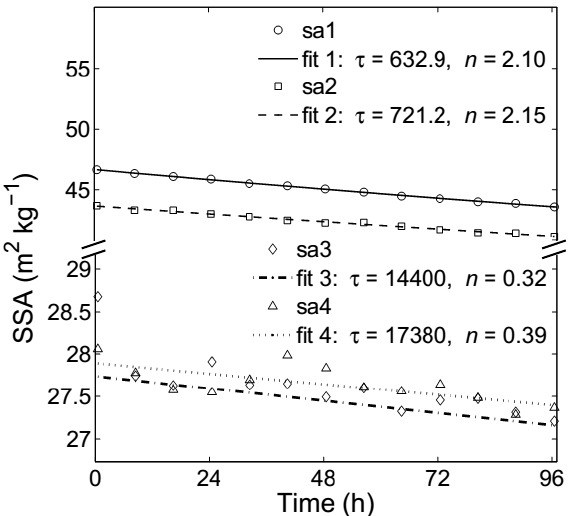
Figure 10. Temporal evolution of the specific surface area, SSA, of the ice matrix obtained by triangulated structure surface method. The computed fit is of the form SSA (t) = SSA 0